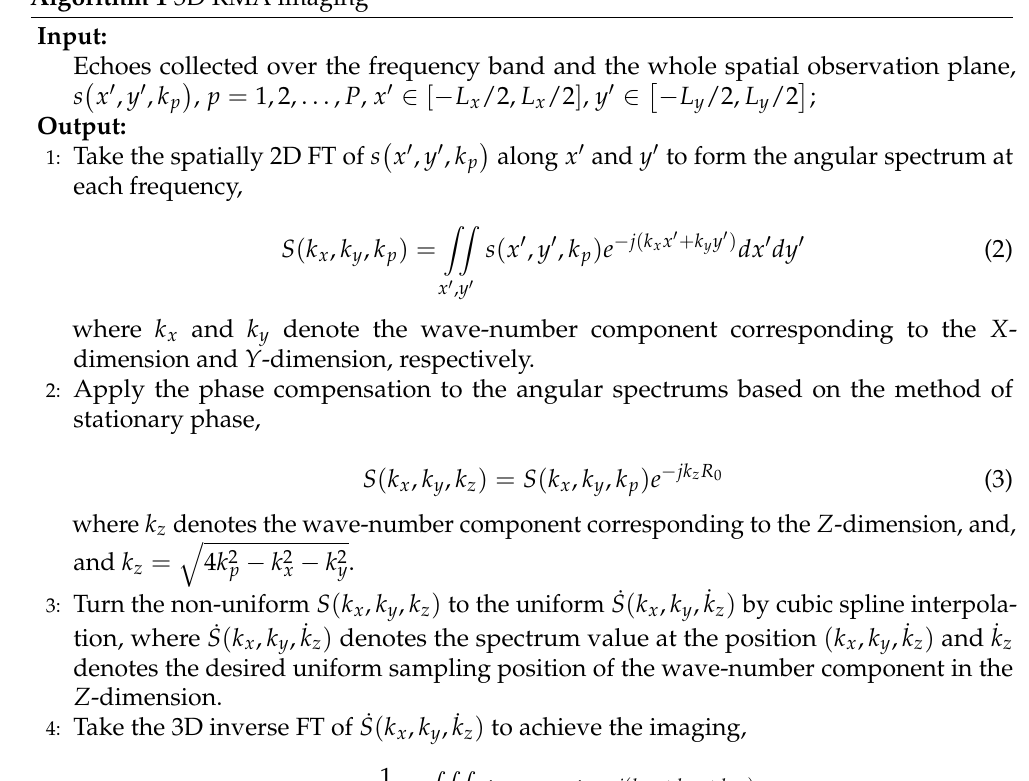
Algorithm 1 3D RMA imaging